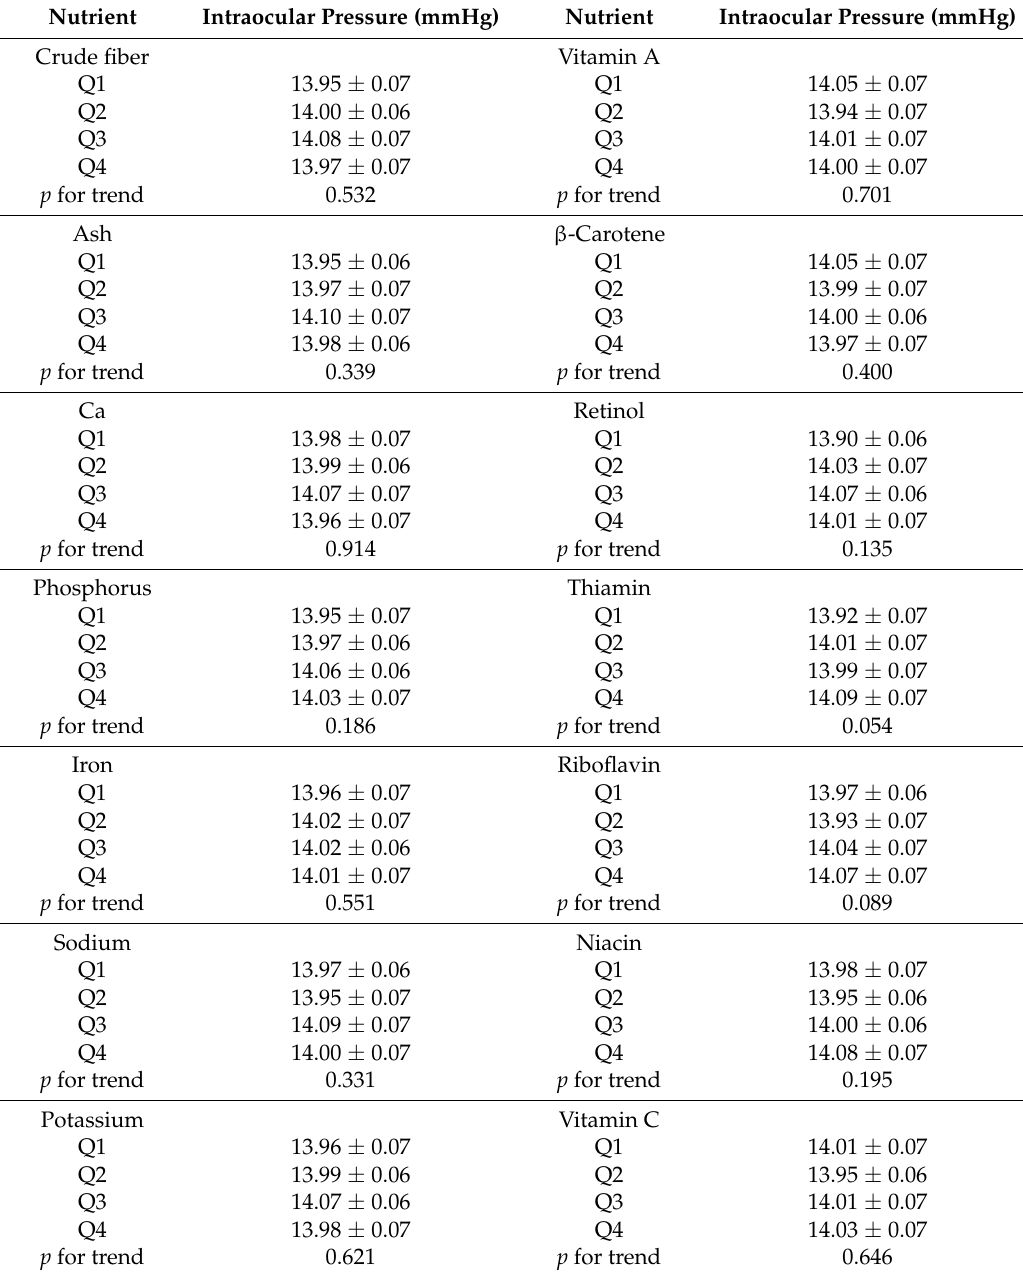
Table 5. Intraocular pressure according to quartiles of nutrient